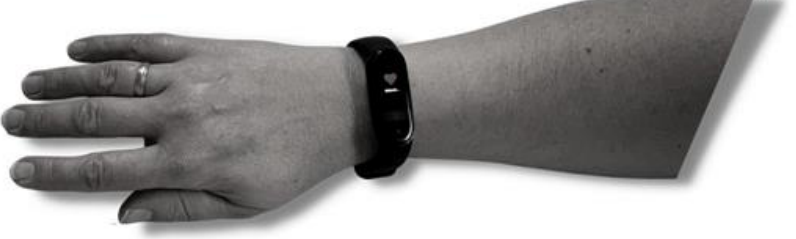
Figure 1. All participants wore the Xiaomi Mi Band 5 on their right arm during the